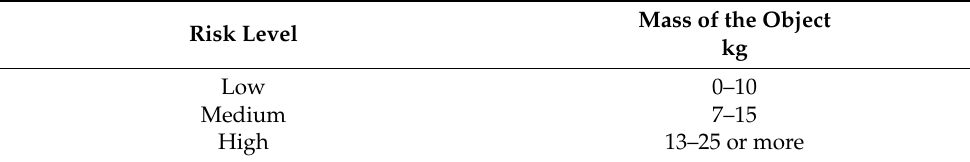
Table 2. Assignment of risk level for the mass of the object to be manipulated.